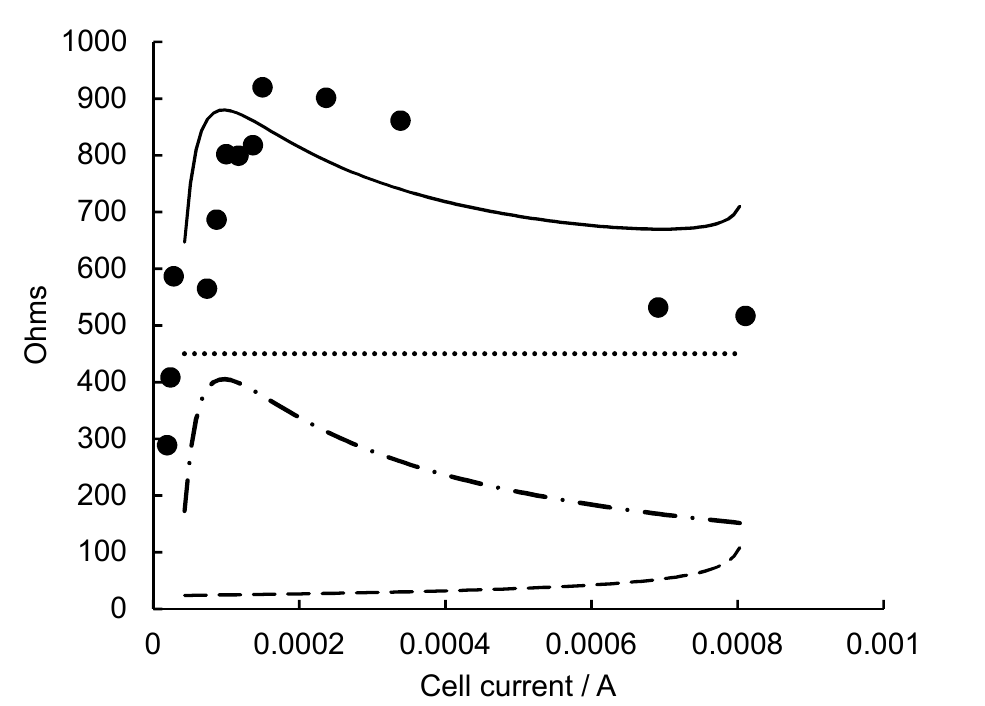
Figure 3. Variation of SMFC resistances at pH 8: experimental R i ( • ) and the predictions of R i (solid line), R act (dashed dotted line), R conc (dashed line), and R ohmic (dotted line).